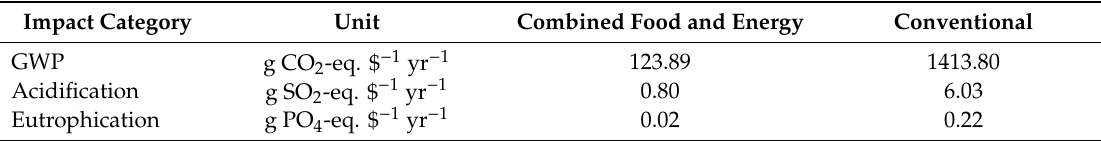
Table 4. Environmental impacts of the conventional wheat and combined food and energy production systems in Denmark. GWP: global warming potential (GWP100a).